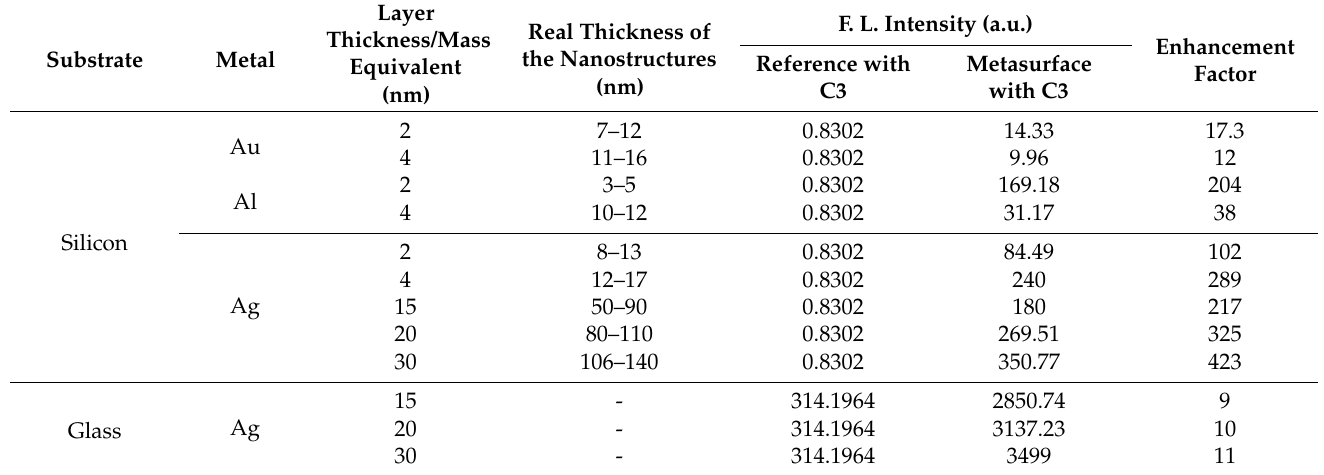
Table 3. Fluorescence enhancement factor attain on metallic films deposited on different substrates.